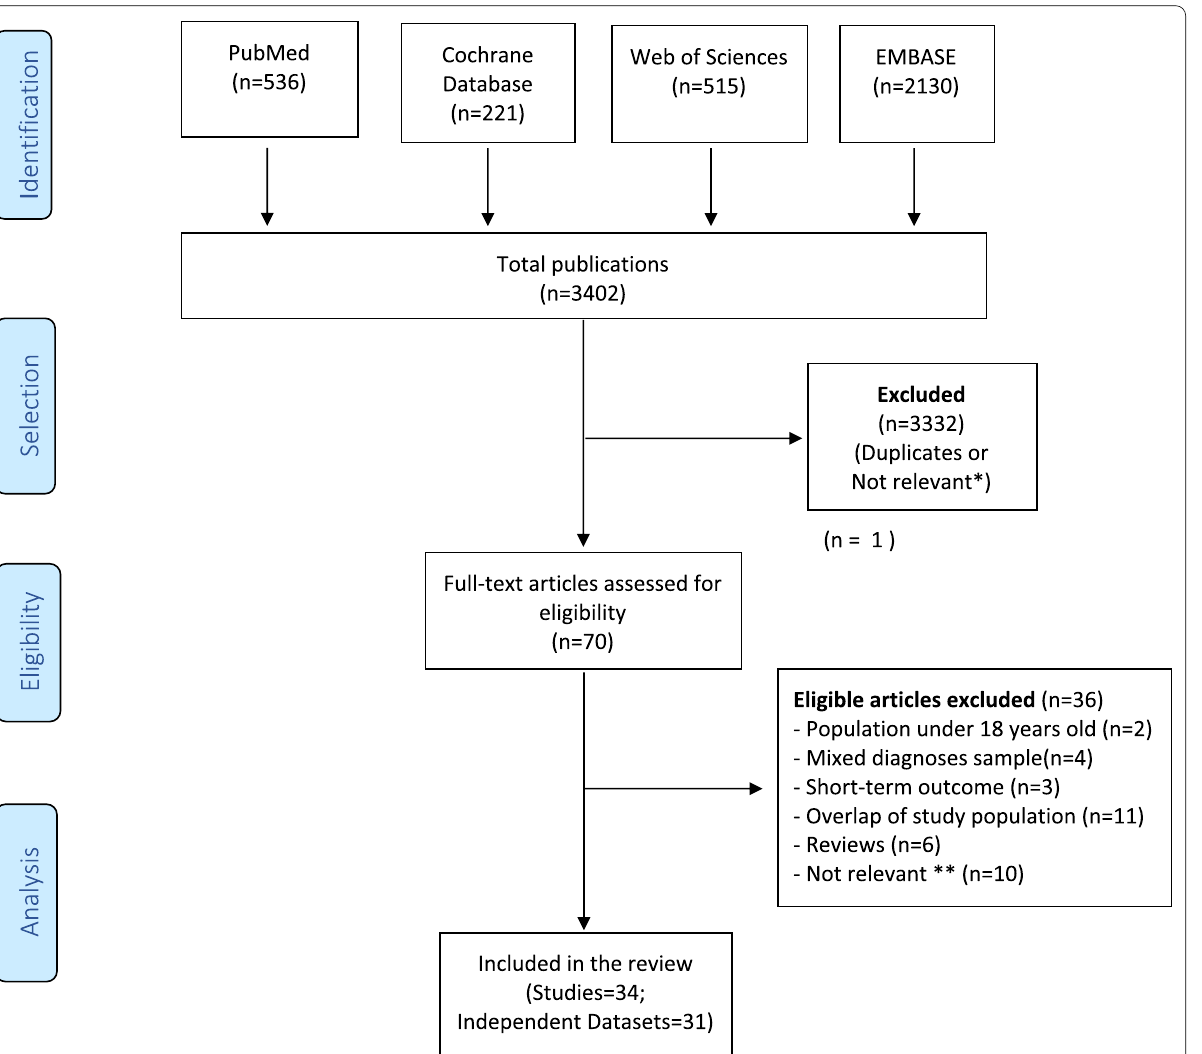
Fig. 1 Flow-chart of articles included in the systematic qualitative analysis. (*) not relevant: keywords met selection criteria, but publication did not represent a study of outcome with Lithium. (**) not relevant: studies failed to meet inclusion criteria regarding predictors or met criterion e.g. comparison of outcome to Li versus other mood